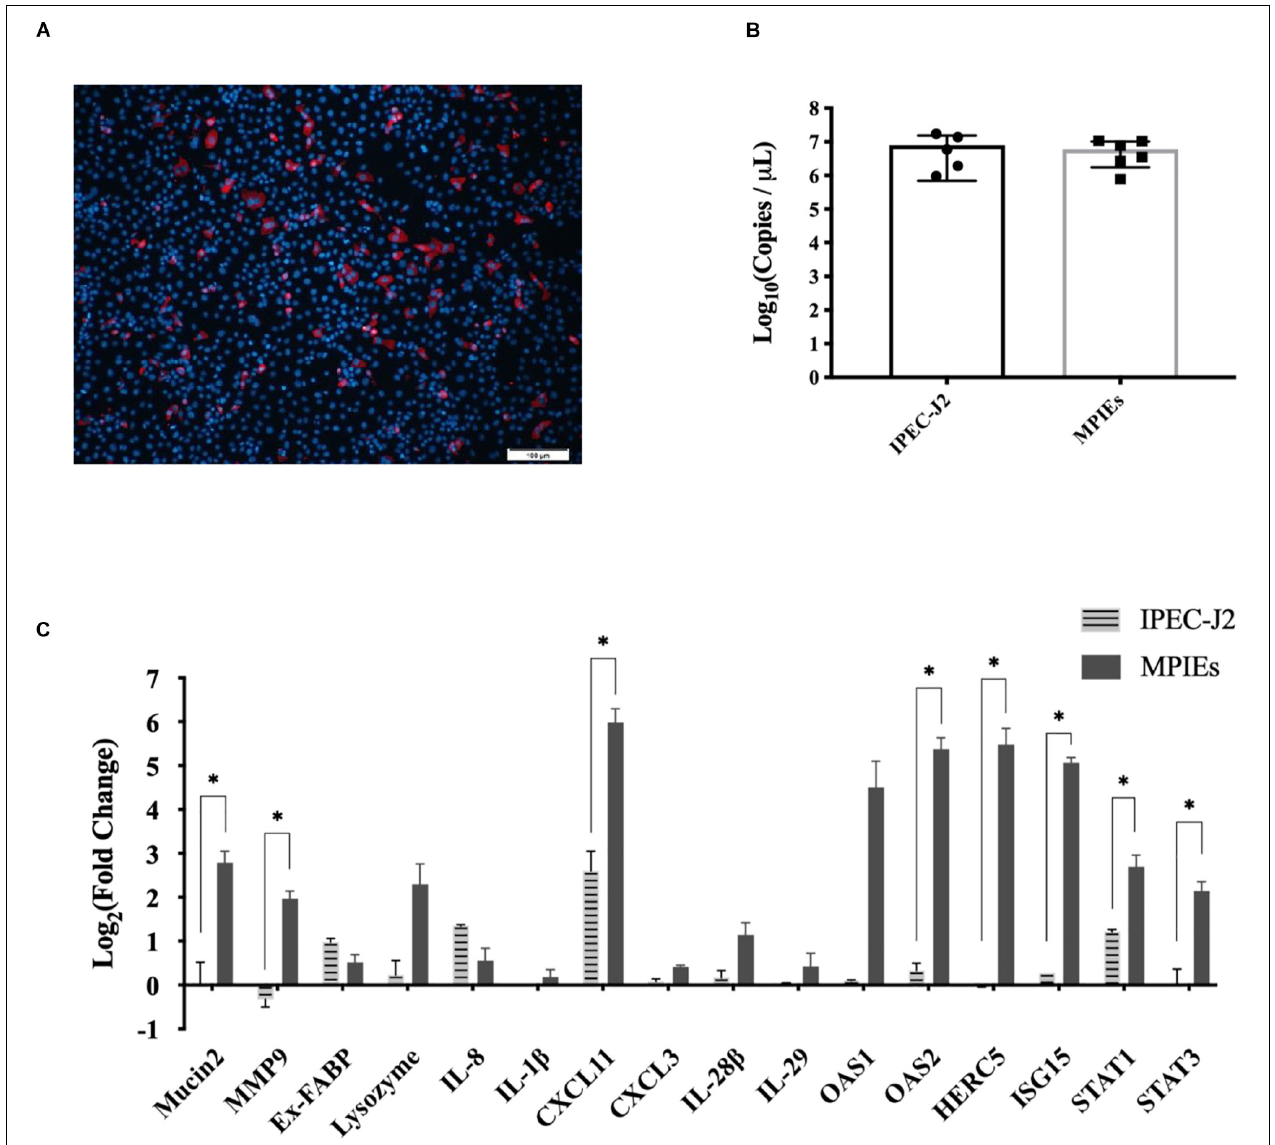
FIGURE 6 | Comparison of innate immune responses of IPEC-J2 and MPIEs to PDCoV infection. (A) Immunostaining of IPEC-J2 cells infected with PDCoV for 48 h. The virus is stained red using the antibody against PDCoV-N. The nucleus is stained blue (Scale bar = 100 µ m). (B) Comparison of PDCoV replication levels in IPEC-J2 and monolayer PIEs by RT-qPCR. The experiment was repeated thrice and the data are shown as mean ± SD. (C) Transcriptional levels of genes indicated above in Enteroids and IPEC-J2 after 24 h of infection with PDCoV using RT-qPCR. Data were normalized to mock-infected controls ( ∗ p < 0.05 and ∗∗ p <